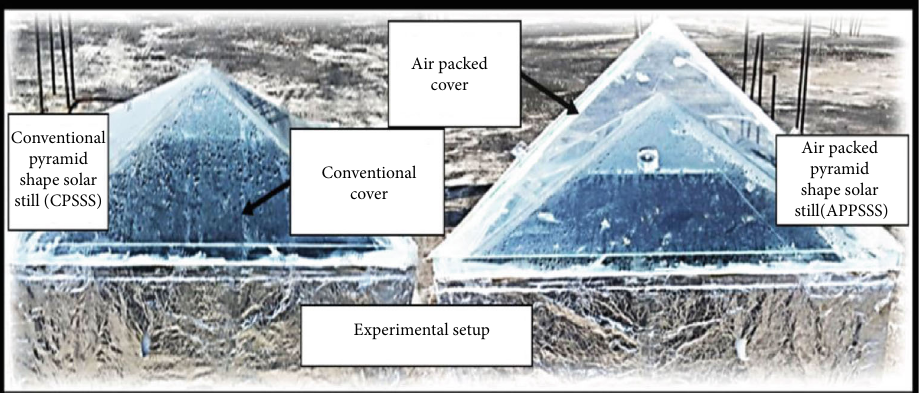
Figure 13: Conventional pyramid and air-packed pyramid-shaped solar still [63].